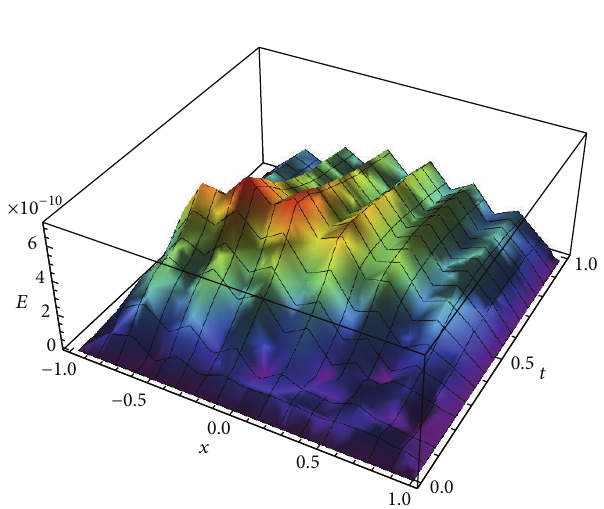
Figure 9: The absolute error of problem (44) where 𝛼 = 𝛽 = 0 and ] = 𝛾 = 10 −2 at 𝑁 = 20 .